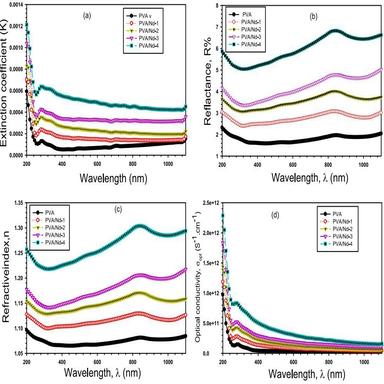
(a) K with λ, (b) R versus λ, (c) n against λ and (d) σopt with λ, for PVA and PVA/Nd2O3.